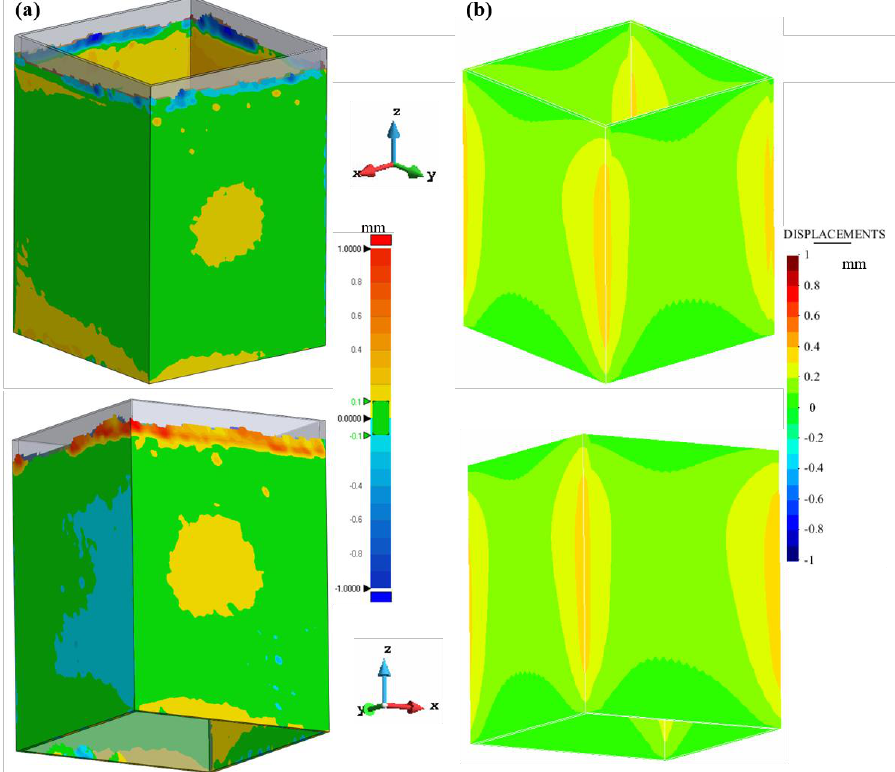
Figure 15. Comparison between the ( a ) experimental and ( b ) simulated displacement distributions of the hollow square part.